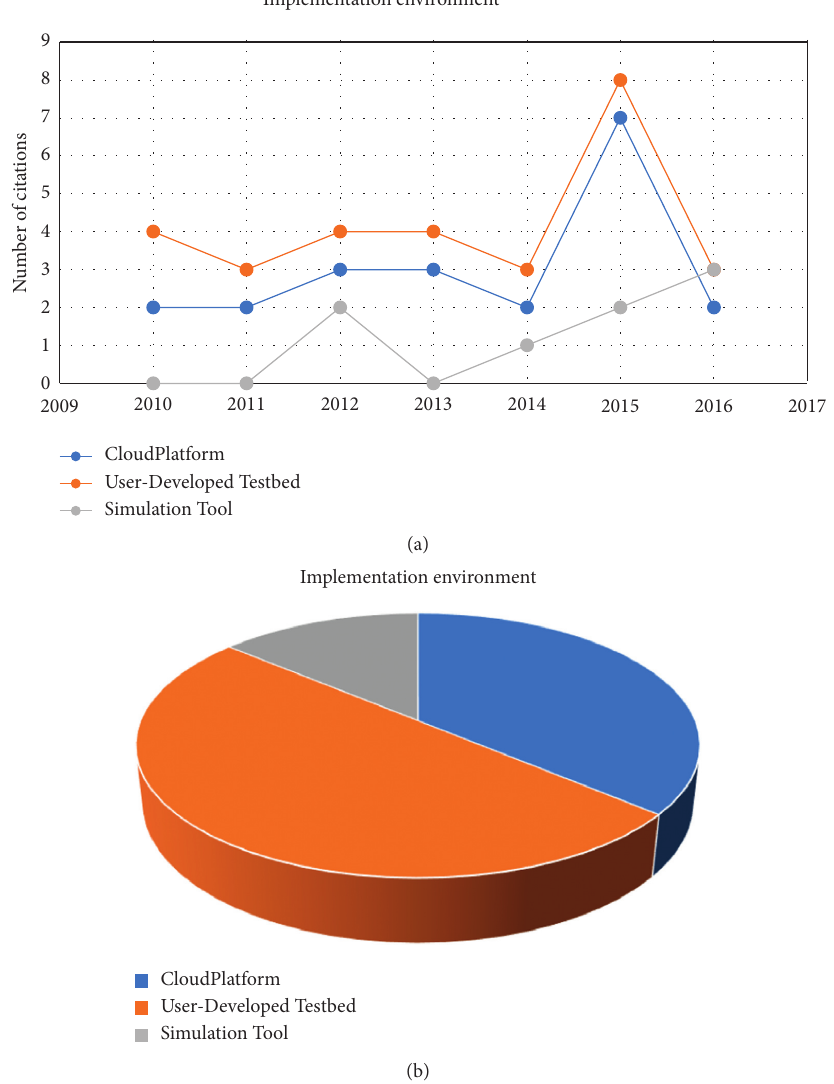
Figure 10: (a, b) Analysis of implementation environment for MCC from the years